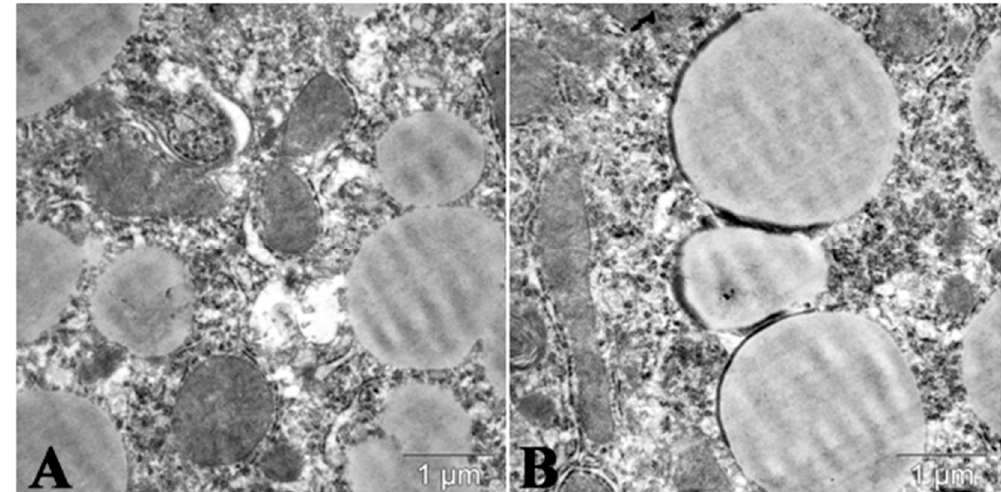
Figure 4. The serum lipid profile of mice with acute lipemia that were drinking a 2% solution of disaccharide trehalose for 10 days before P-407 administration. * p < 0.01 as compared to the control.